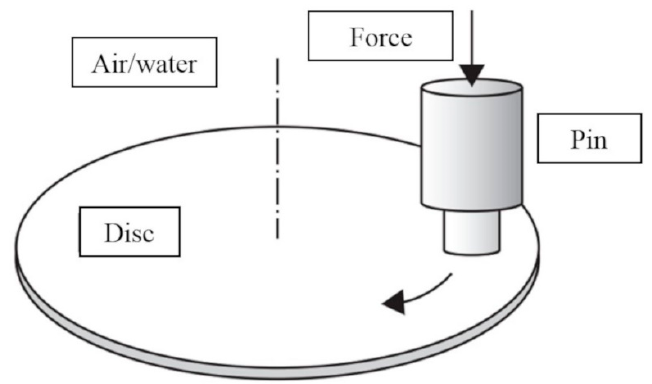
Figure 4. The concept of tribological examination in the pin − disc friction system.